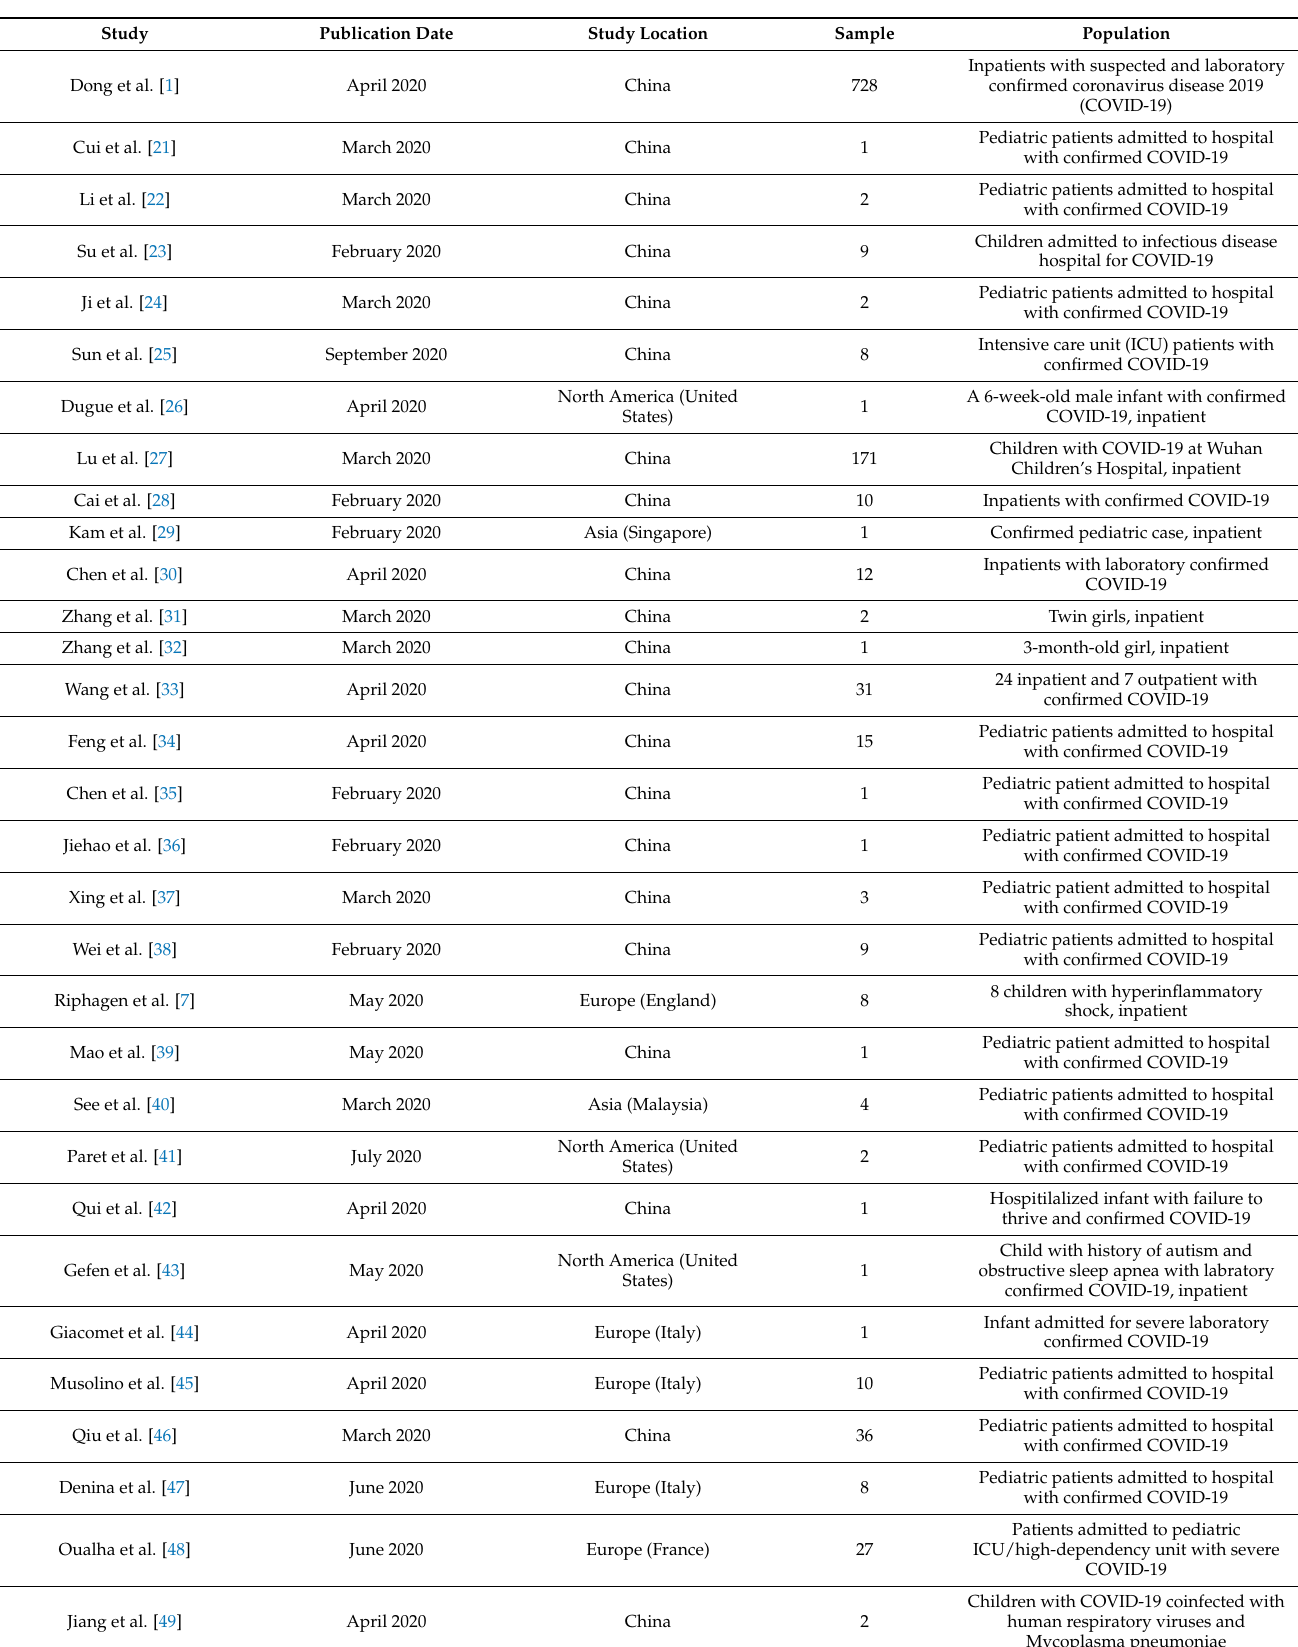
Table 1. Characteristics of the studies included in the